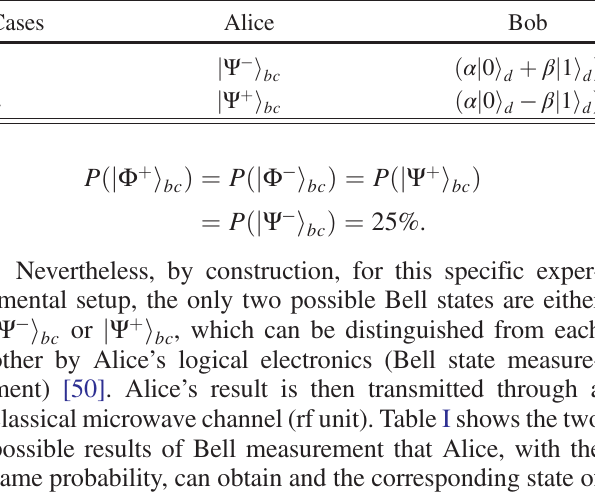
TABLE I. Alice ’ s state and Bob ’ s corresponding state.